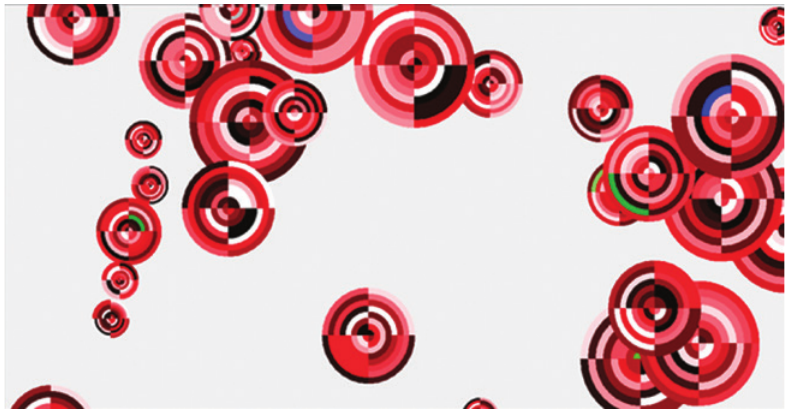
Figure 8: Best Individual from Experiment 10.